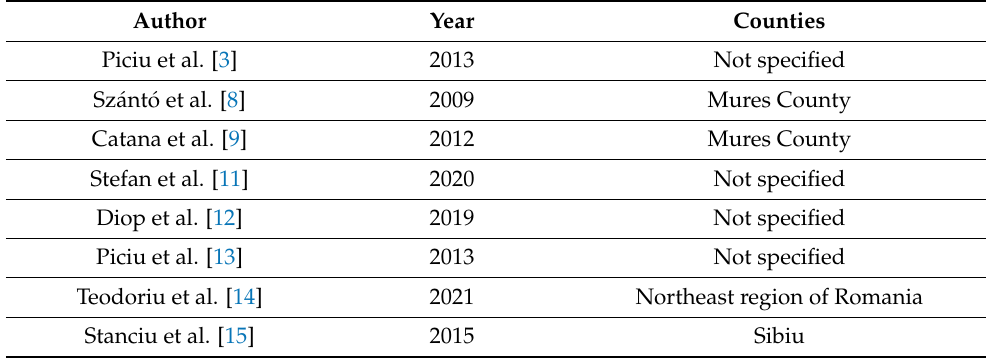
Table 3. Studies on radiation-induced thyroid carcinoma in Romania due to the Chernobyl nuclear